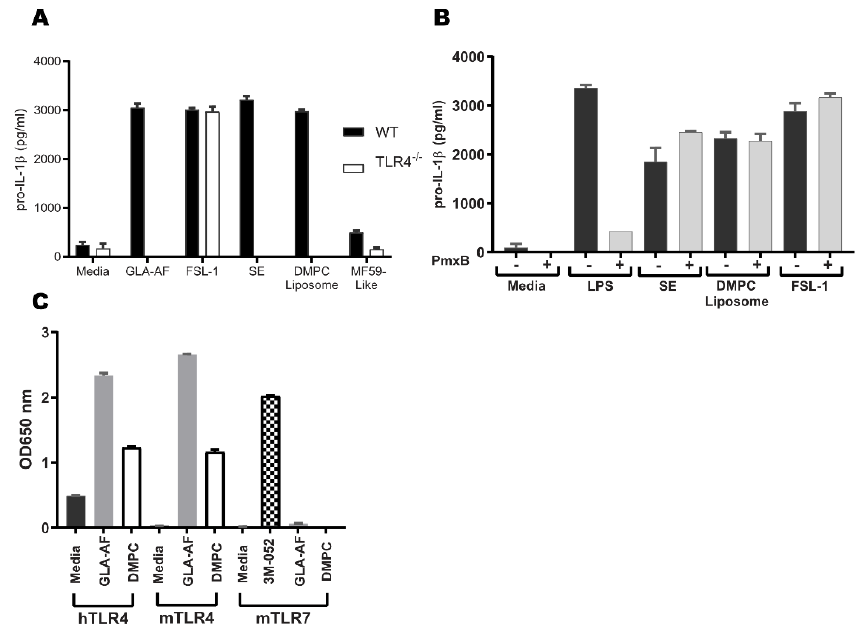
Figure 3. DMPC activates human and murine TLR4 pathway. ( A ) DMPC recapitulates the pro-IL- 1β production of SE in a TLR4 -dependent manner. WT and TLR4 −/− BMDCs were stimulated with media, GLA, SE, DMPC liposomes, or MF59-like emulsion for 5 h. Lysate was collected and assayed for pro-IL- 1β by ELISA. ( B ) SE and DMPC stimulation of pro-IL- 1β production is not a result of endotoxin contamination. WT BMDCs were stimulated with media, LPS, SE, DMPC liposomes, or MF59-like emulsion pretreated with polymyxin B (PmxB) for 5 h. Lysate was collected and assayed for pro-IL- 1β by ELISA. ( C ) DMPC has activity in both human and murine TLR4s. HEK reporter cells transfected with murine (m) or human (h) TLR4 or murine TLR7 were stimulated with media, GLA-AF, DMPC liposomes, or 3M052-AF (TLR7/8 ligand) for 44 h. The production of SEAP induced by NF- κB and AP -1 activation triggered by TLR4 or TLR7 ligand stimulation was measured at OD 650. Data are shown as the mean +/- SEM of a representative with each condition performed in triplicate. Data are representative of three experiments with similar results.